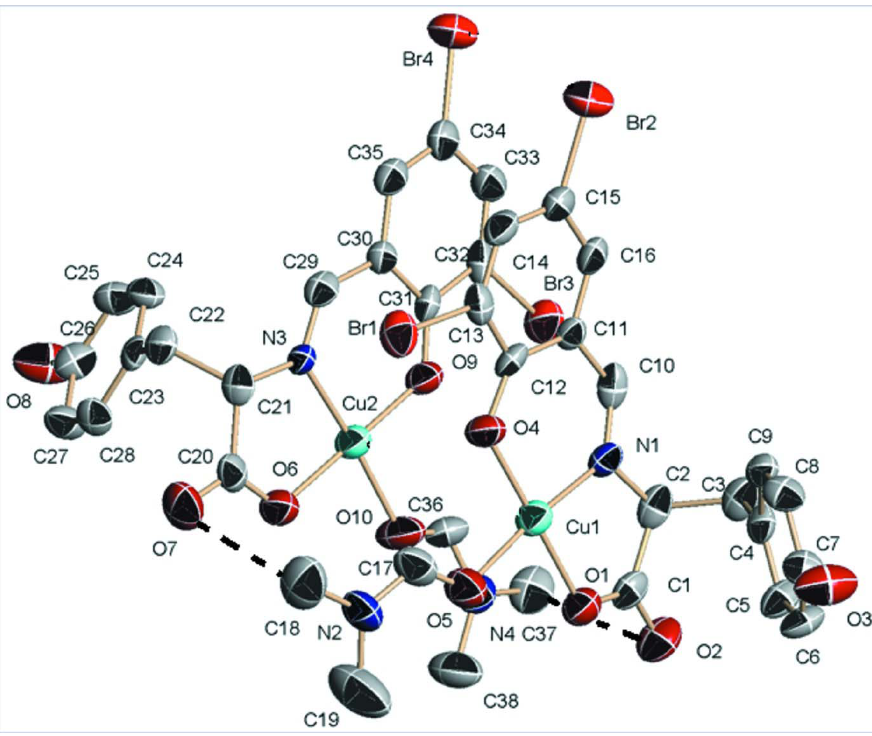
Figure 1 The asymmetric unit of (I), with 30% probability displacement ellipsoids for non-H atoms. Hydrogen atoms have been omitted and C—H···O hydrogen bonds are drawn as dashed lines.